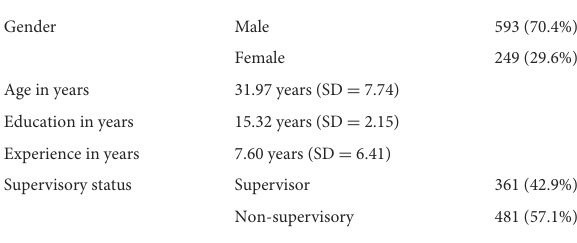
TABLE 1 Demographics of the